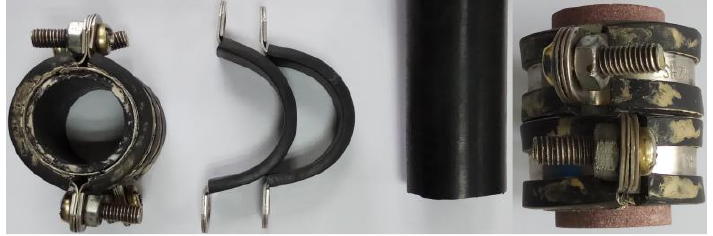
Figure 6. The transversal clamping device for core with oblique fracture.